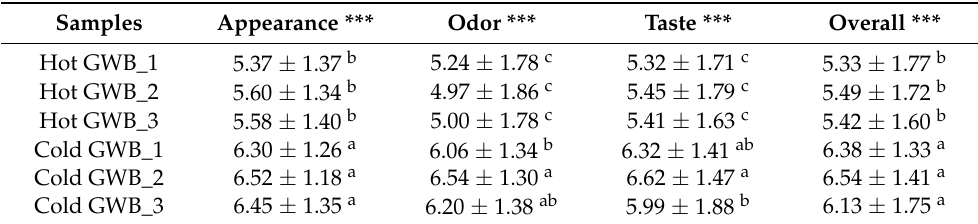
Table 6. Consumer acceptability of germinated wheat